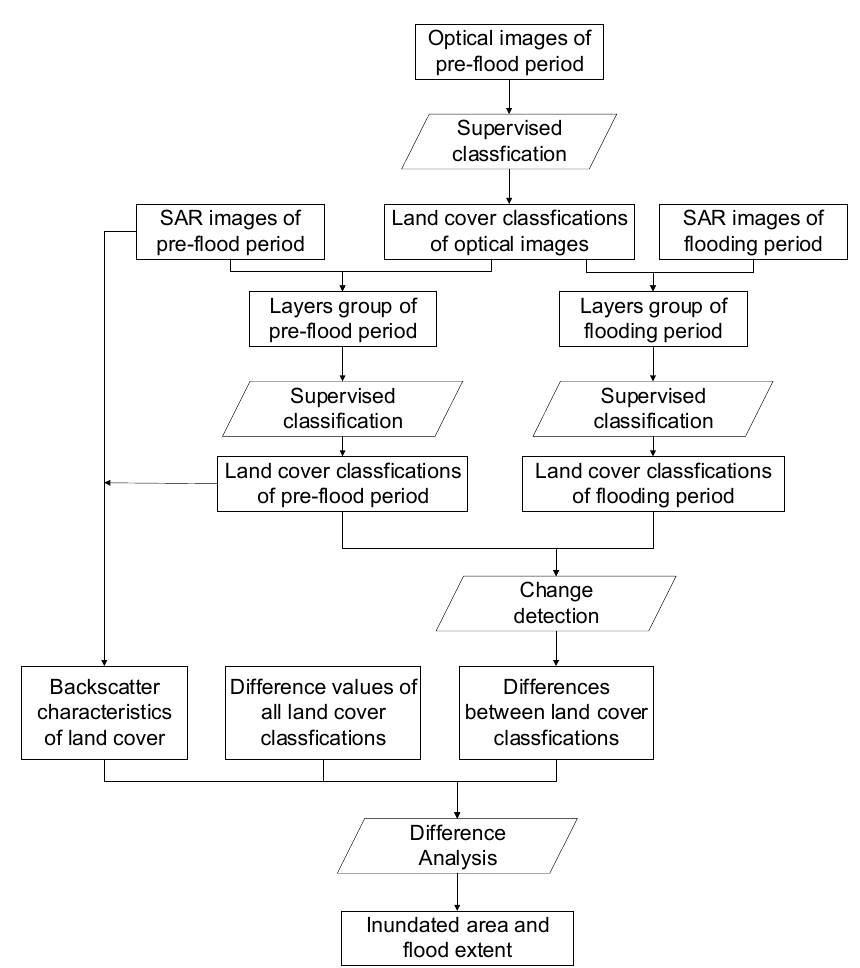
Figure 2. The flow chart of rapid flood mapping using Sentinel-1 ground range detected (GRD) images and Sentinel-2 images.